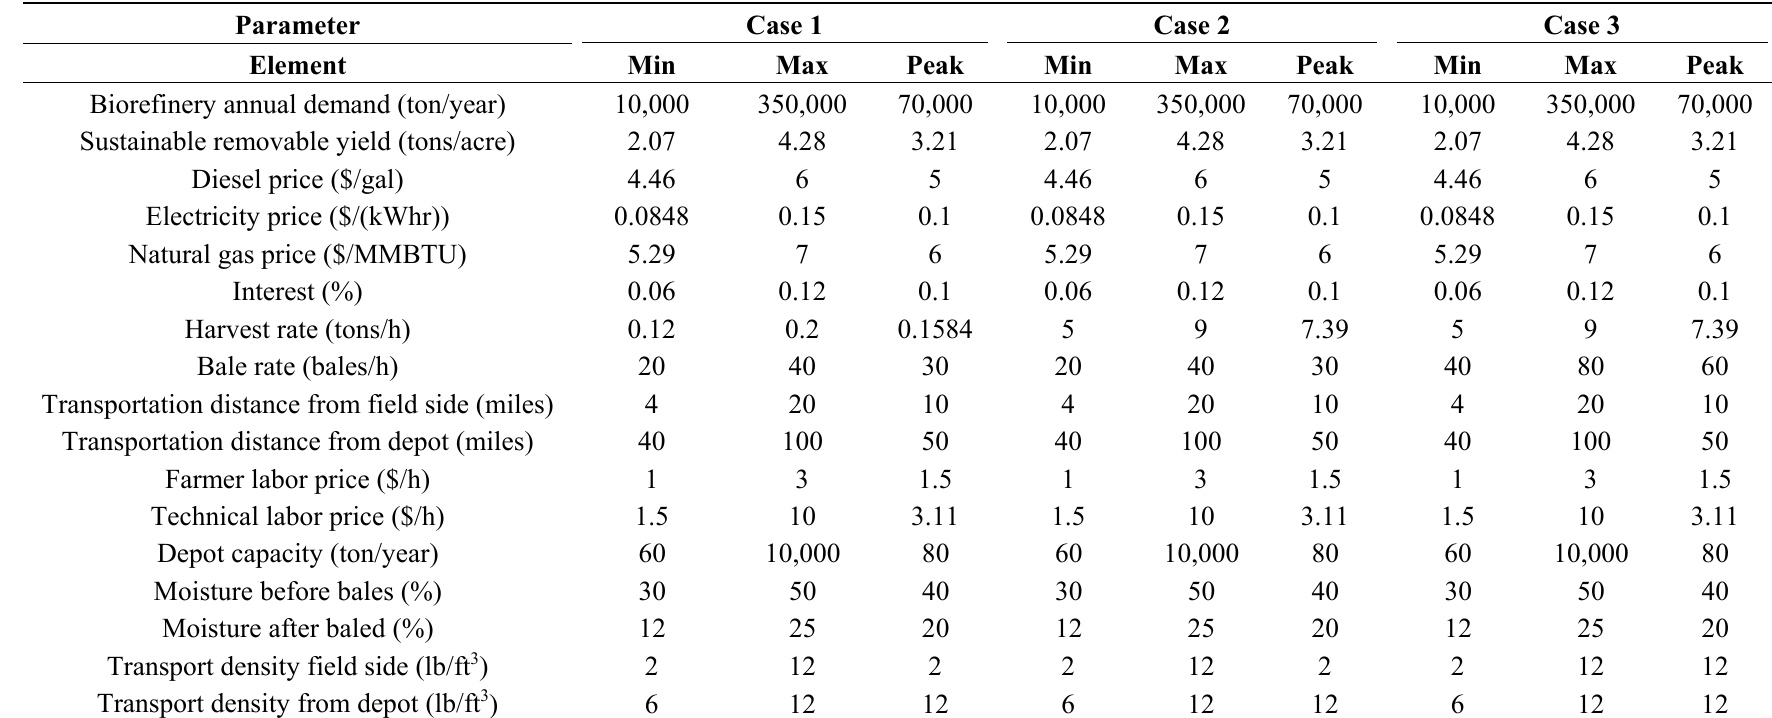
Table 3. Parameters and distribution variables chosen for sensitivity analysis of corn